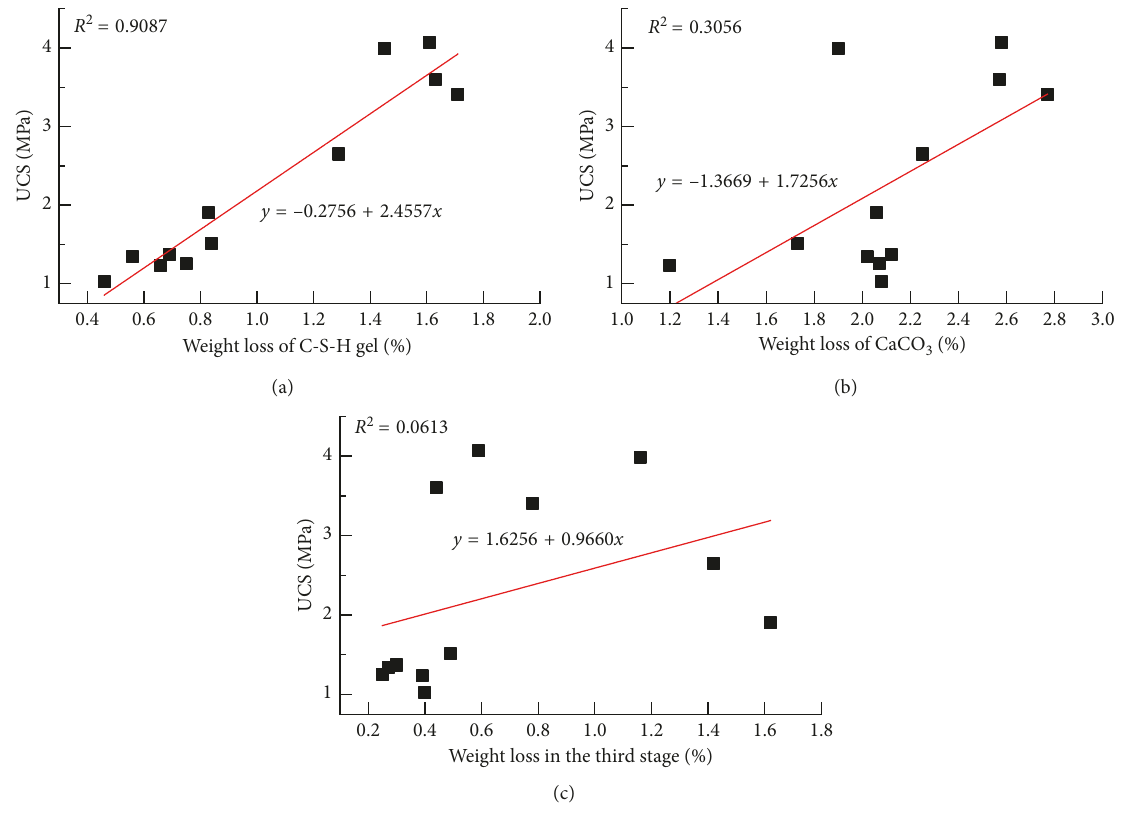
Figure 10: Fitting diagrams of weight loss of hydration products and UCS of GP-CTB (mass concentration 70%). (a) Fitting diagram of weight loss of C-S-H gel and UCS of GP-CTB; (b) fitting diagram of weight loss of CaCO 3 and UCS of GP-CTB; (c) fitting diagram of weight loss in third stage and UCS of